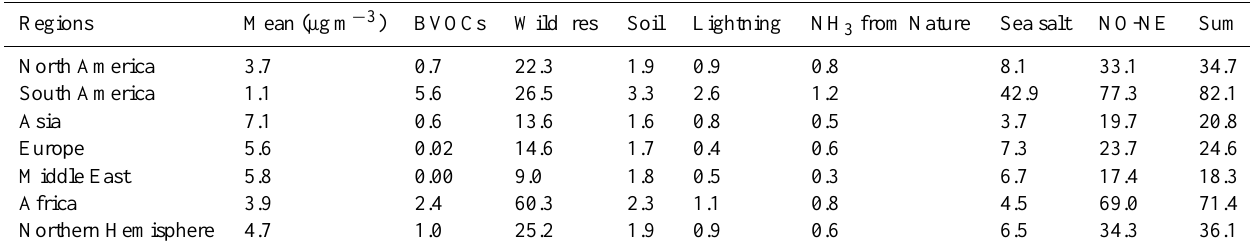
Table 5. Relative contributions (%) of the natural sources to annual average PM 2 . 5 concentrations in 2006. The impacts of natural emissions of SNO x (NO x from soils), LNO x (NO x from lightning), BVOCs, together with emissions from wildfires, natural NH 3 , and sea salt on PM 2 . 5 level are showed. They are calculated for the DEHM mother domain used in this study (Northern Hemisphere), as well as for the six individual regions. Mean annual PM 2 . 5 concentrations (µgm − 3 ) averaged over each region (Mean) are shown for the control case including all emission